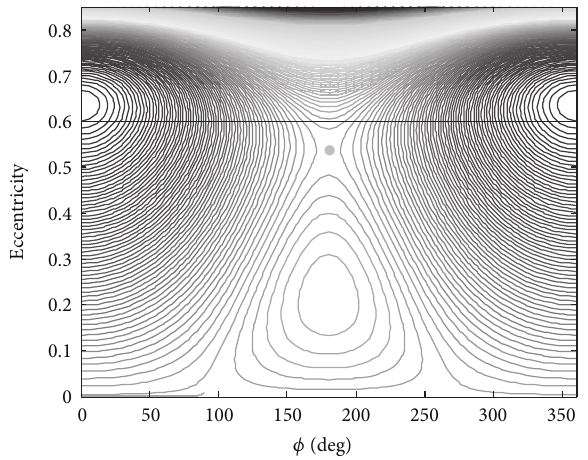
Figure 4: Hyperbolic regime in the eccentricity- 𝜙 phase space evolution under the effects of 𝐽 2 + SRP: the bold lines represent the separatrices in correspondence of the saddle point and zero eccentricity Hamiltonian